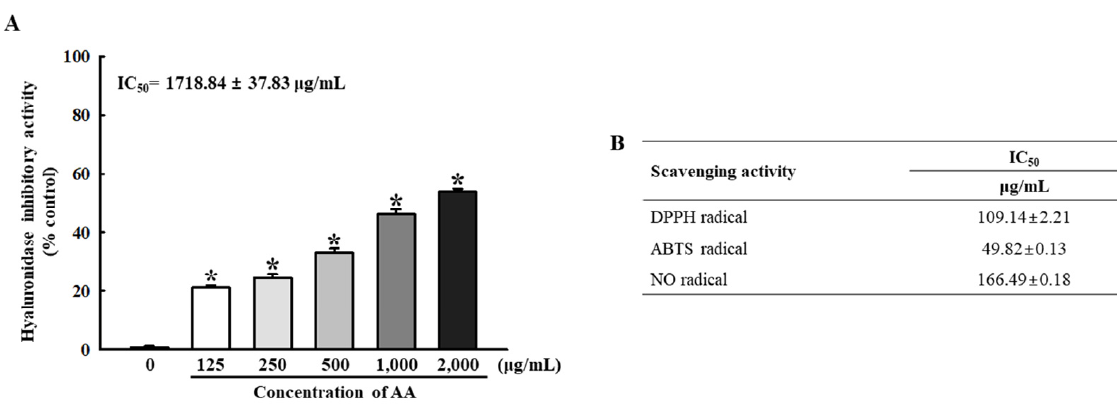
Figure 2. Biochemical properties of AA. ( A ) hyaluronidase HAase activity of AA was calculated by the relative proportion of the sample to the control group after the measurement of optical density at 540 nm. HAase activity analysis was performed with three AA samples in duplicate. ( B ) Radical scavenging activity of AA. These activities against DPPH, ABTS, and NO radicals were measured with a mixture that included appropriate concentrations of radicals and varying concentrations of AA. These levels of AA are represented as IC 50 values. The scavenging activity of three radicals was analyzed using three AA samples in duplicate. All values in the results are represented as the means ± standard deviation (SD). * indicates statistical significance compared to the non-treated group. Abbreviations: AA, abietic acid; DPPH, 2,2-diphenyl-1-picrylhydrazyl; HAase, hyaluronidase; ABTS, 2,2 (cid:48) -azino-bis (3-ethylbenzothiazoline-6-sulfonic acid); NO, nitric